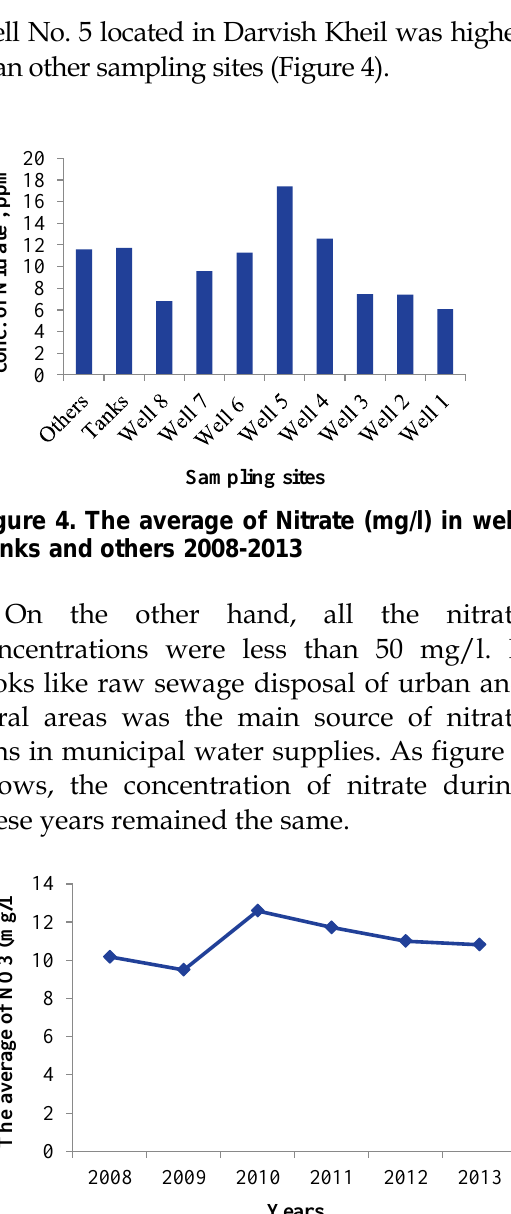
Figure 5. The average of Nitrate (mg/l) by year 2008-2013